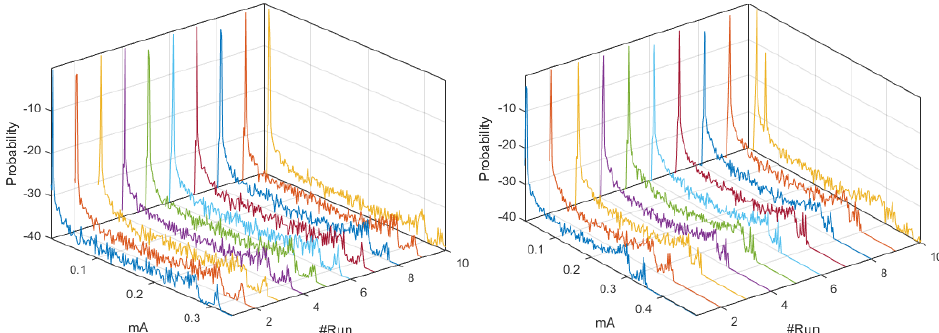
Figure 11. M-mode of pdf with distinctive characteristics for Coordinator Node of the ZigBee network: ( Left ) at 9600 bauds; and ( Right ) at 57,600